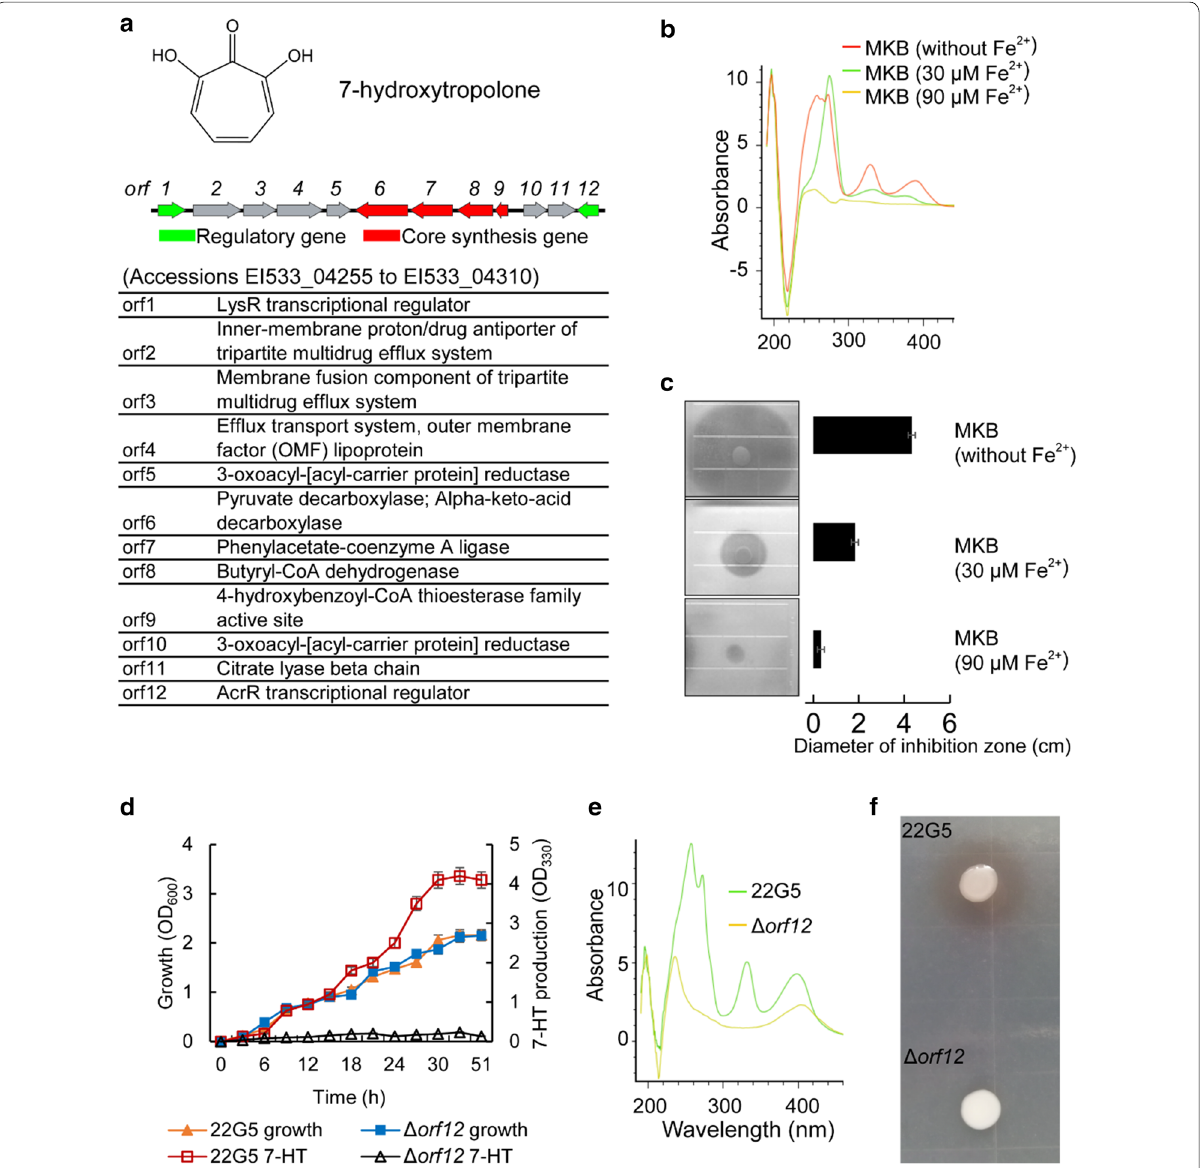
Fig. 4. 7-HT biosynthesis and inhibition of V. dahliae . a Gene cluster for 7-HT (Jiang et al. 2016). b , c Absorption spectra of 7-HT production and phenotypes in zone of inhibition assay using 7-HT extraction from the supernatant of 22G5 culture in MKB media with or without FeSO 4 . d Growth trace of wild type 22G5 (22G5) and orf12 mutant (Δ orf12 ) (displayed by OD 600 , left y-axis) and its corresponding 7-HT production (displayed by OD 330 , right y-axis). e , f Absorption spectra of 7-HT production and phenotypes in zone of inhibition assay in wild type 22G5 (22G5) and orf12 mutant (Δ orf12